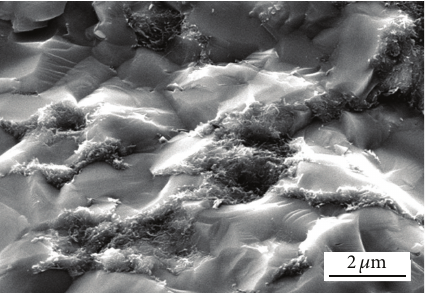
Figure 7: SEM micrograph of fracture surfaces of the sample.